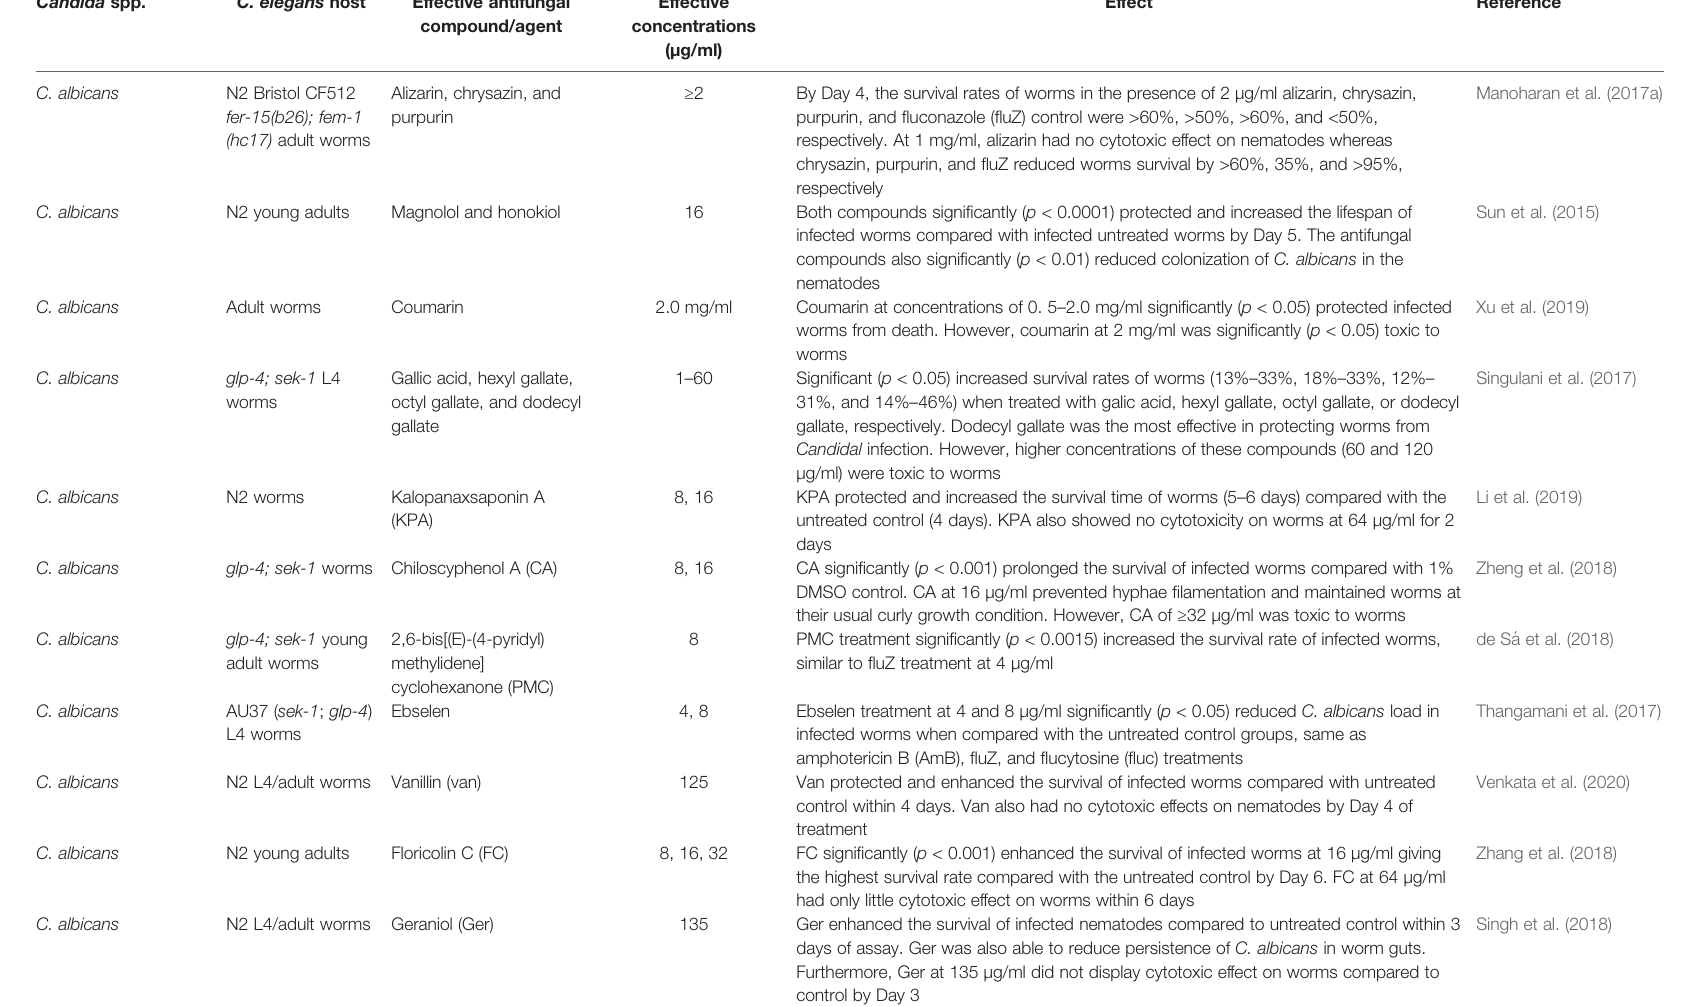
TABLE 2 | Evaluation of anticandidal bioactive compounds in the C. elegans model. Candida